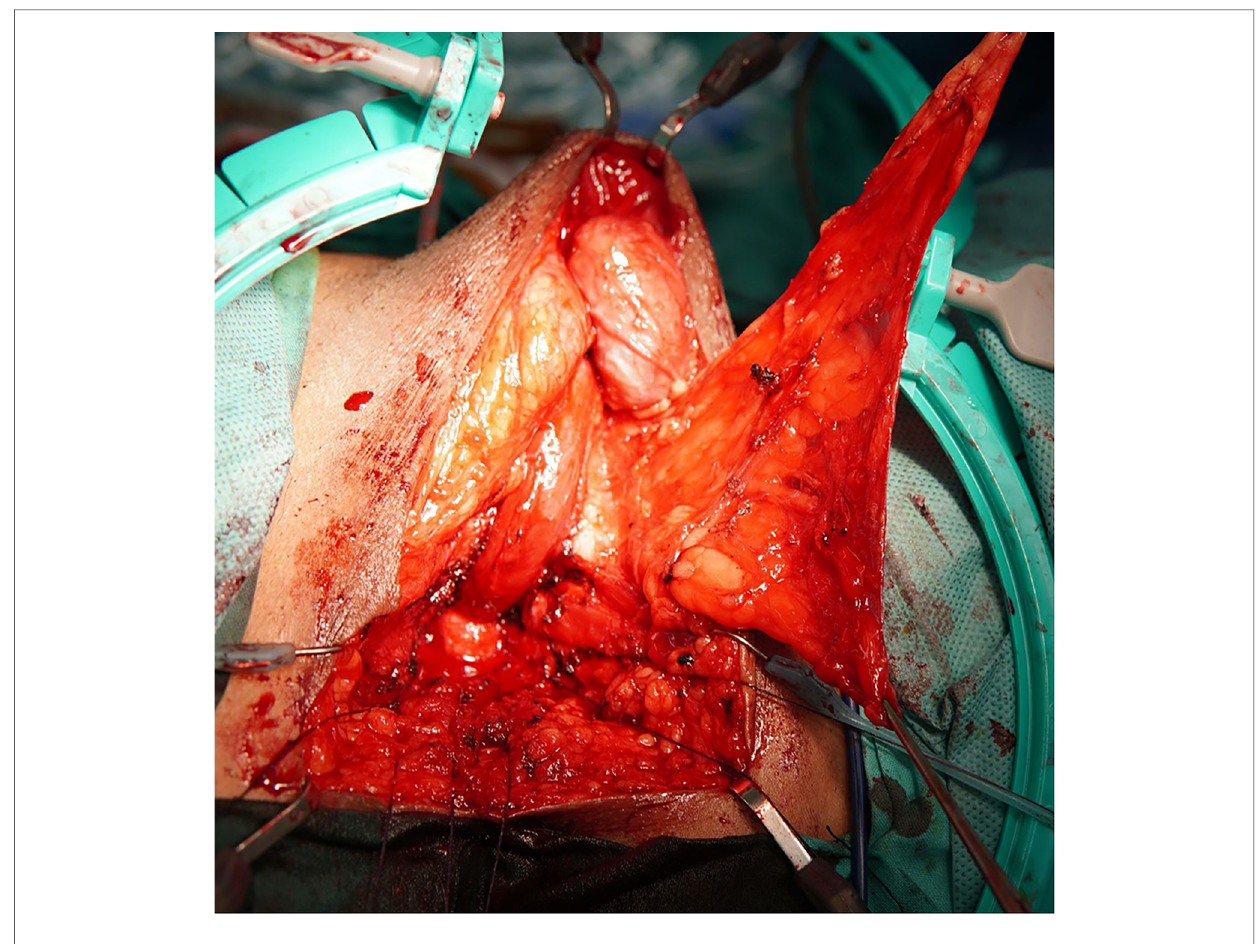
FIGURE 3 The harvest of the pedicel scrotal membrane fl